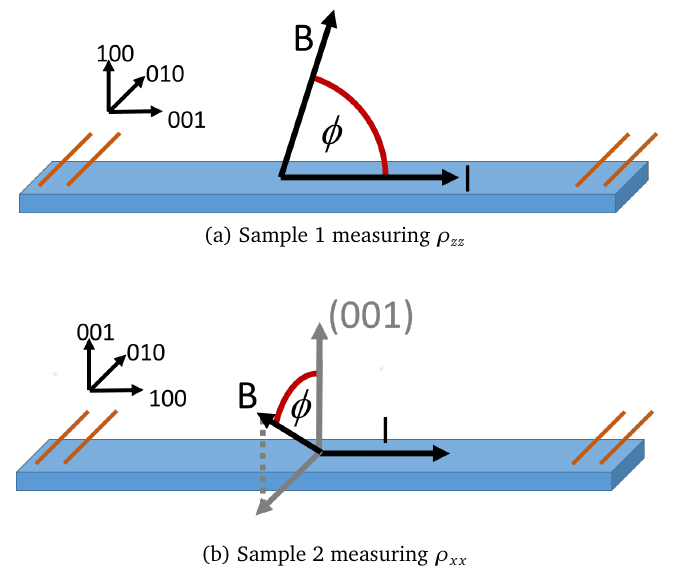
Figure 1: Current and magnetic field orientations for c-axis and in-plane magnetore- sistance